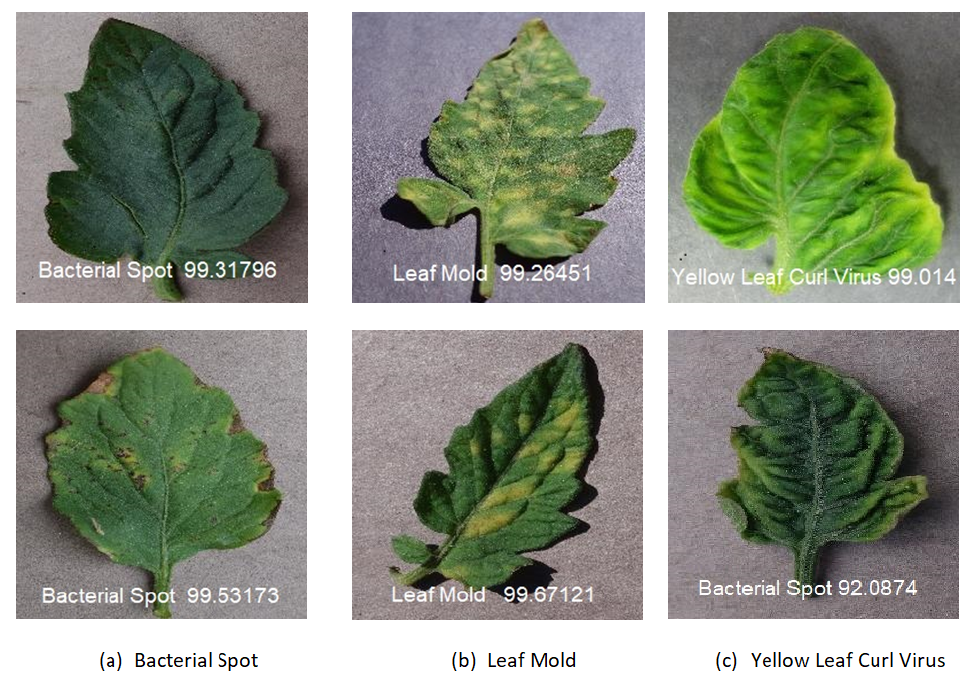
Figure 10. The examples of identification results of tomato plant diseases on the test